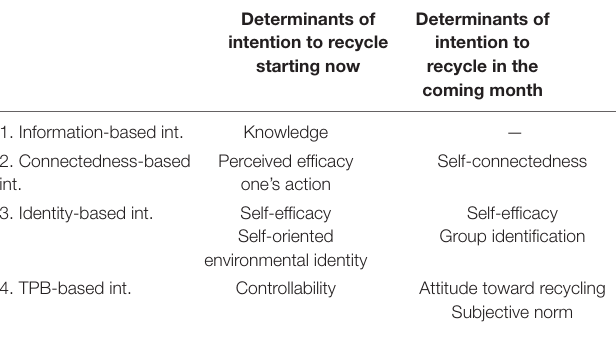
TABLE 4 | Behavioral determinants highlighted in each of the